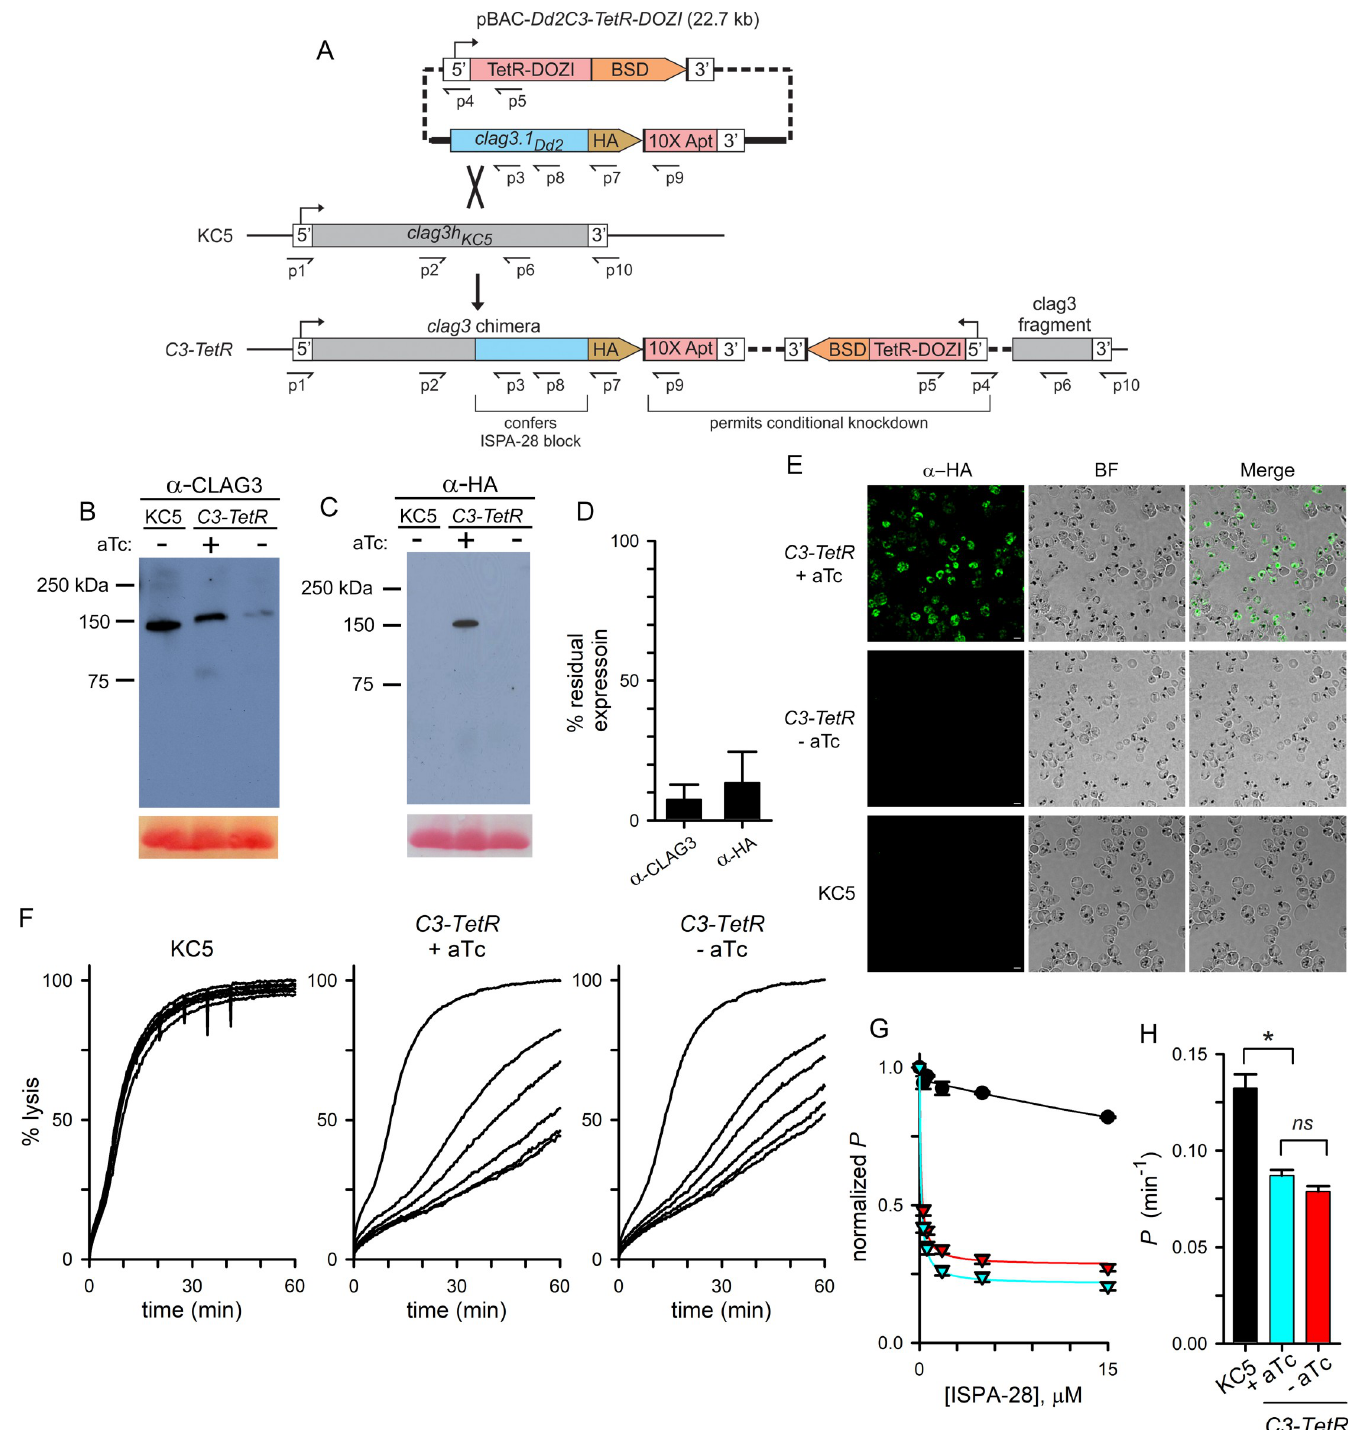
Fig 2. CLAG3 conditional knockdown reveals complex effects on channel pharmacology and transport rates. (A) Allelic exchange strategy for production of a chimeric clag3 gene and conditional knockdown. The TetR-DOZI conditional regulator and blasticidin S deaminase (BSD) are expressed under a single promoter and separated by a viral 2A skip peptide [75, not illustrated]. A C-terminal HA epitope tag (HA) is appended to the clag3 gene and is followed by a stop codon and a 10x aptamer sequence (10X Apt) embedded in the 3’ UTR. Primer positions are shown as used for PCR results in S2 Fig; primer sequences are listed in S2 Table. (B-C) Immunoblots using total cell lysates from indicated parasites cultivated with or without 2 μ M aTc, probed with CLAG3- or HA epitope tag-specific antibody (panels B and C, respectively). Bottom shows Ponceau S staining of hemoglobin as a loading control. (D) Digital quantification of residual CLAG3 expression upon aTc removal